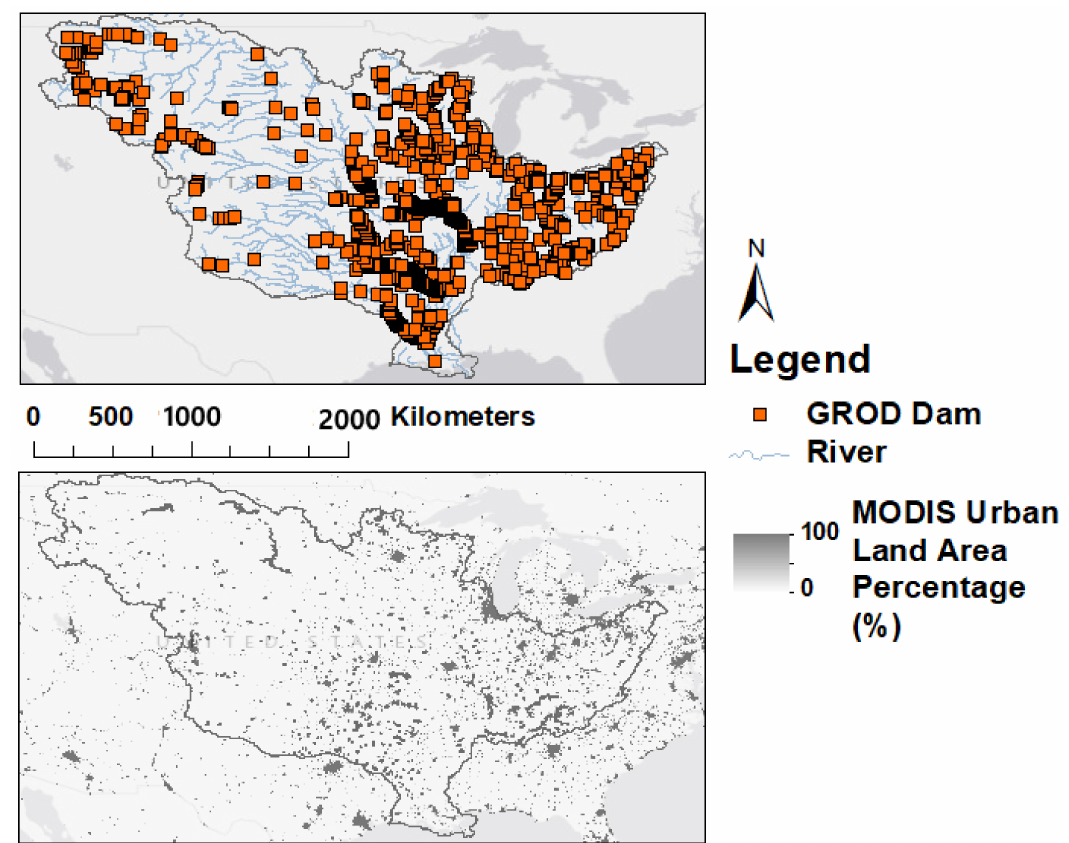
Figure 3. The Mississippi River Basin outline showing the Global River Obstruction Database (GROD)’s “Dams” class with MERIT Hydro rivers (top) and the MODIS “Urban and Built-up Lands” layer that gives a percentage of urban area per 0.05 degree of land area